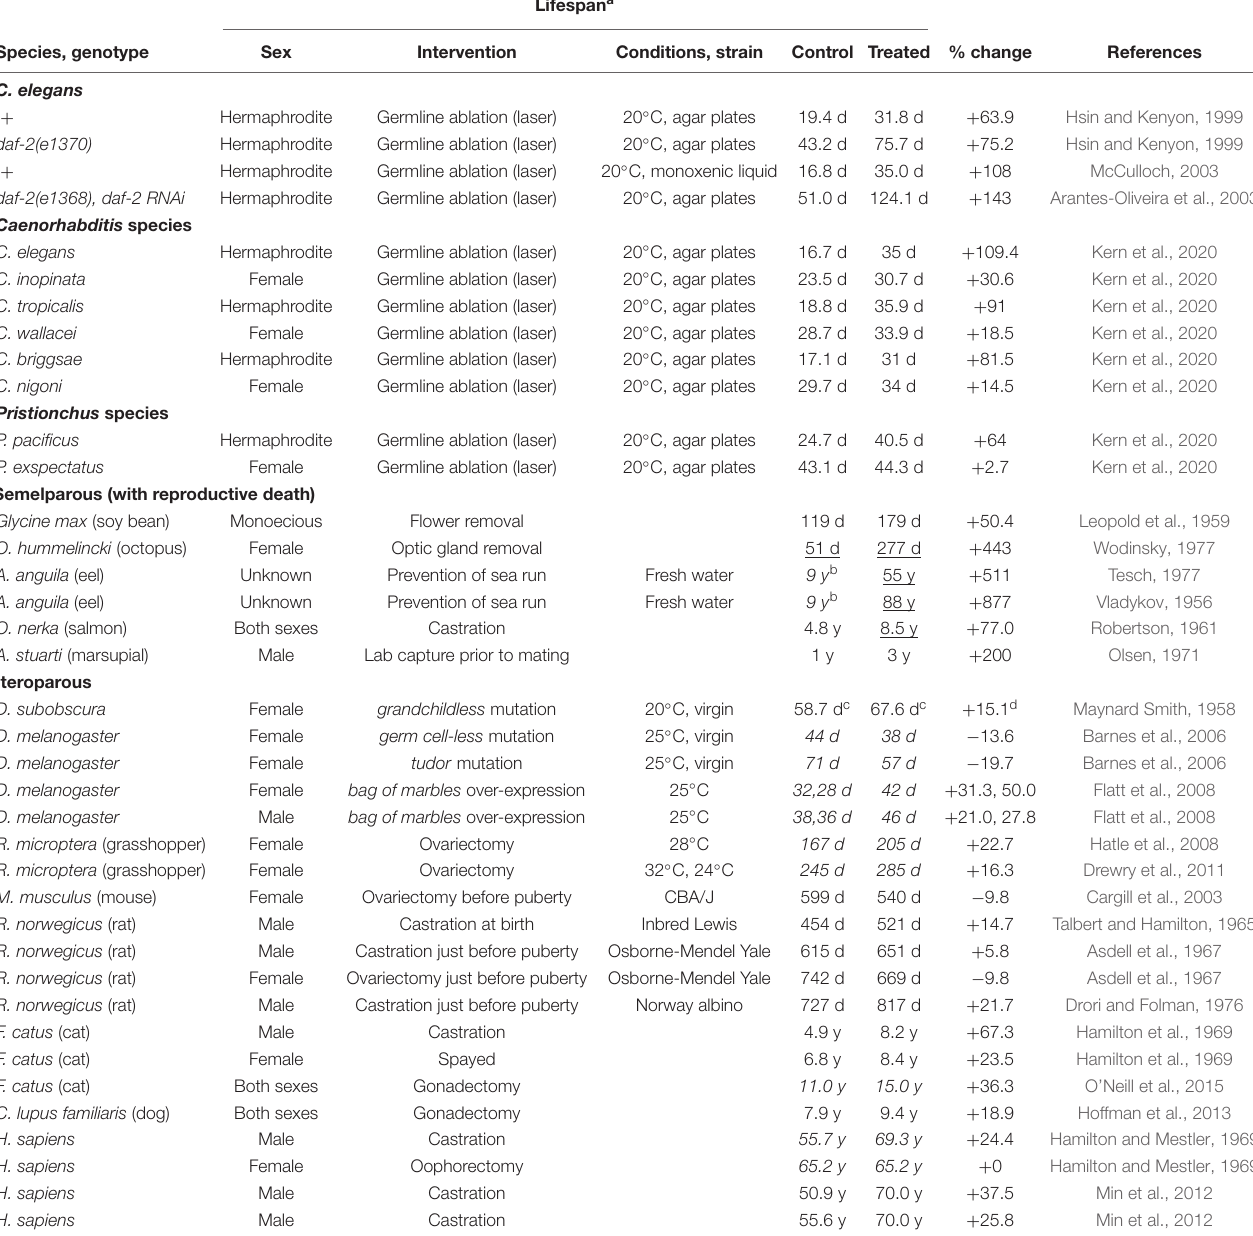
TABLE 1 | Magnitude of increases in lifespan after gonadectomy or behavioral interventions that prevent reproductive